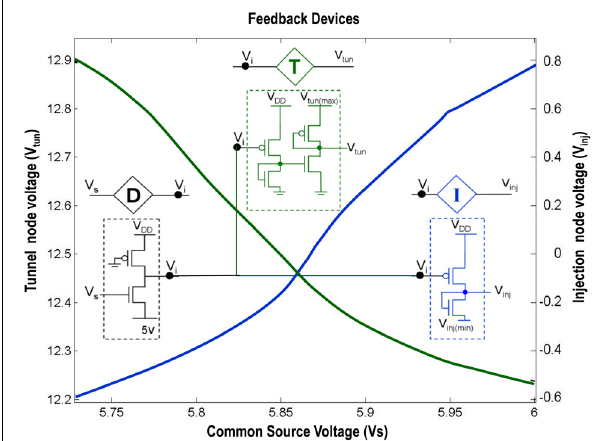
FIGURE 2 | Shows the circuit level description of the Injection (I), Tunnel (T) and Buffer (D) devices that are a part of the ts-WTA circuit shown in Figure 1A. The Injection (I) and Tunnel (T) devices modify the voltage at V i to appropriate ranges that enable injection and tunneling to occur in the floating gate pFETs. The buffer device (D) shields the common source node (V s ) from the loading effect of neighboring cells. The graphs show how the tunnel (V tun ) and injection (V inj ) voltages vary with the common source voltage. Here V inj ( min ) is set to − 0 . 65V, V tun ( max ) is set to 13.6V and V DD is